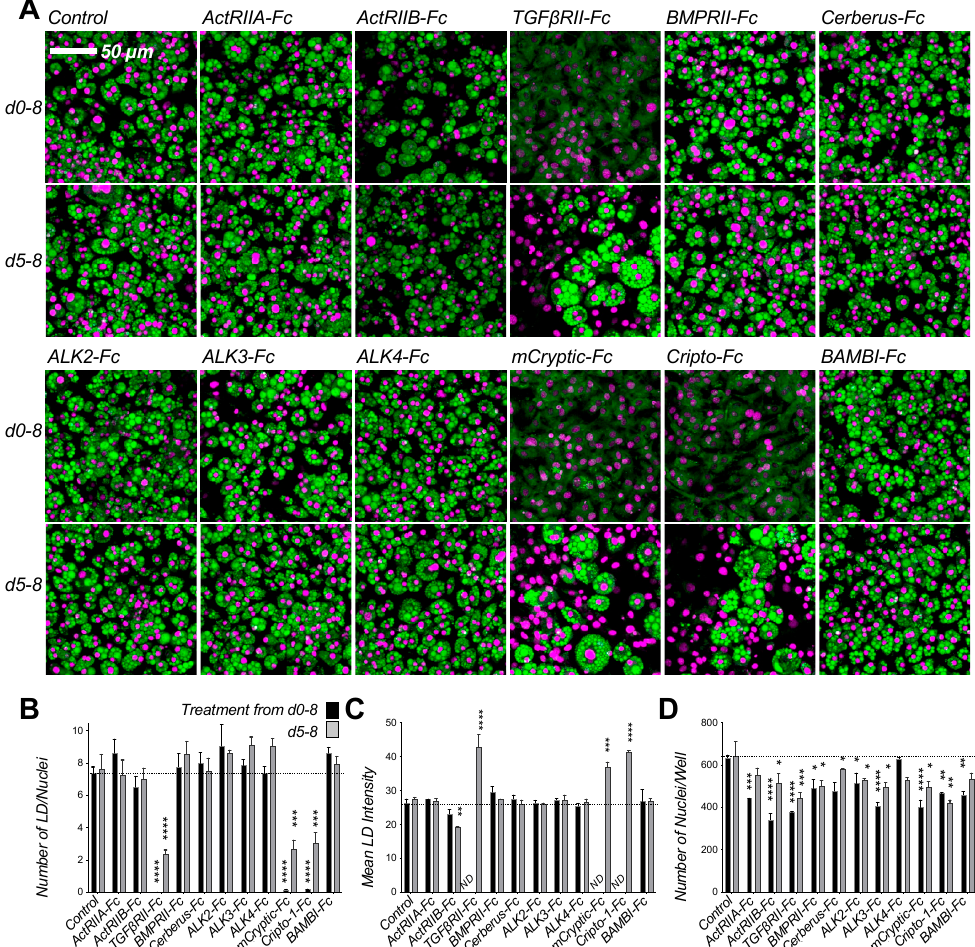
Figure 3. Differentiation assay screen identifies traps with anti-adipogenic activity. ( A ) 3T3-L1 cells were grown in the presence of 300 nM Fc-fusion traps or vehicle control (PBS) as noted. Cells were treated from day 0 (top panel) or day 5 (bottom panel) of differentiation until day 8. Cells were fixed at day 8 and stained for lipids using Nile red (green), nuclei were counter-stained with DAPI (magenta). Cells treated with TGF β RII-Fc, mCryptic-Fc, or Cripto-1-Fc show significantly reduced lipid droplet formation. Each trap captures a unique group of ligands (ST1). Quantitative analysis of 3T3-L1 samples treated with ligands beginning at day 0 (black) or day 5 (grey) of differentiation. Confocal images were analyzed using ImageJ and Prism 9. Statistical significance from two biological replicates was calculated by two-way ANOVA and Dunnett’s multiple comparisons test (* p < 0.05; ** p < 0.01; *** p < 0.001; **** p < 0.0001). ( B ) Total number of lipid droplets (LD) per well. ( C ) Mean lipid droplet intensity. ( D ) Number of nuclei per well.